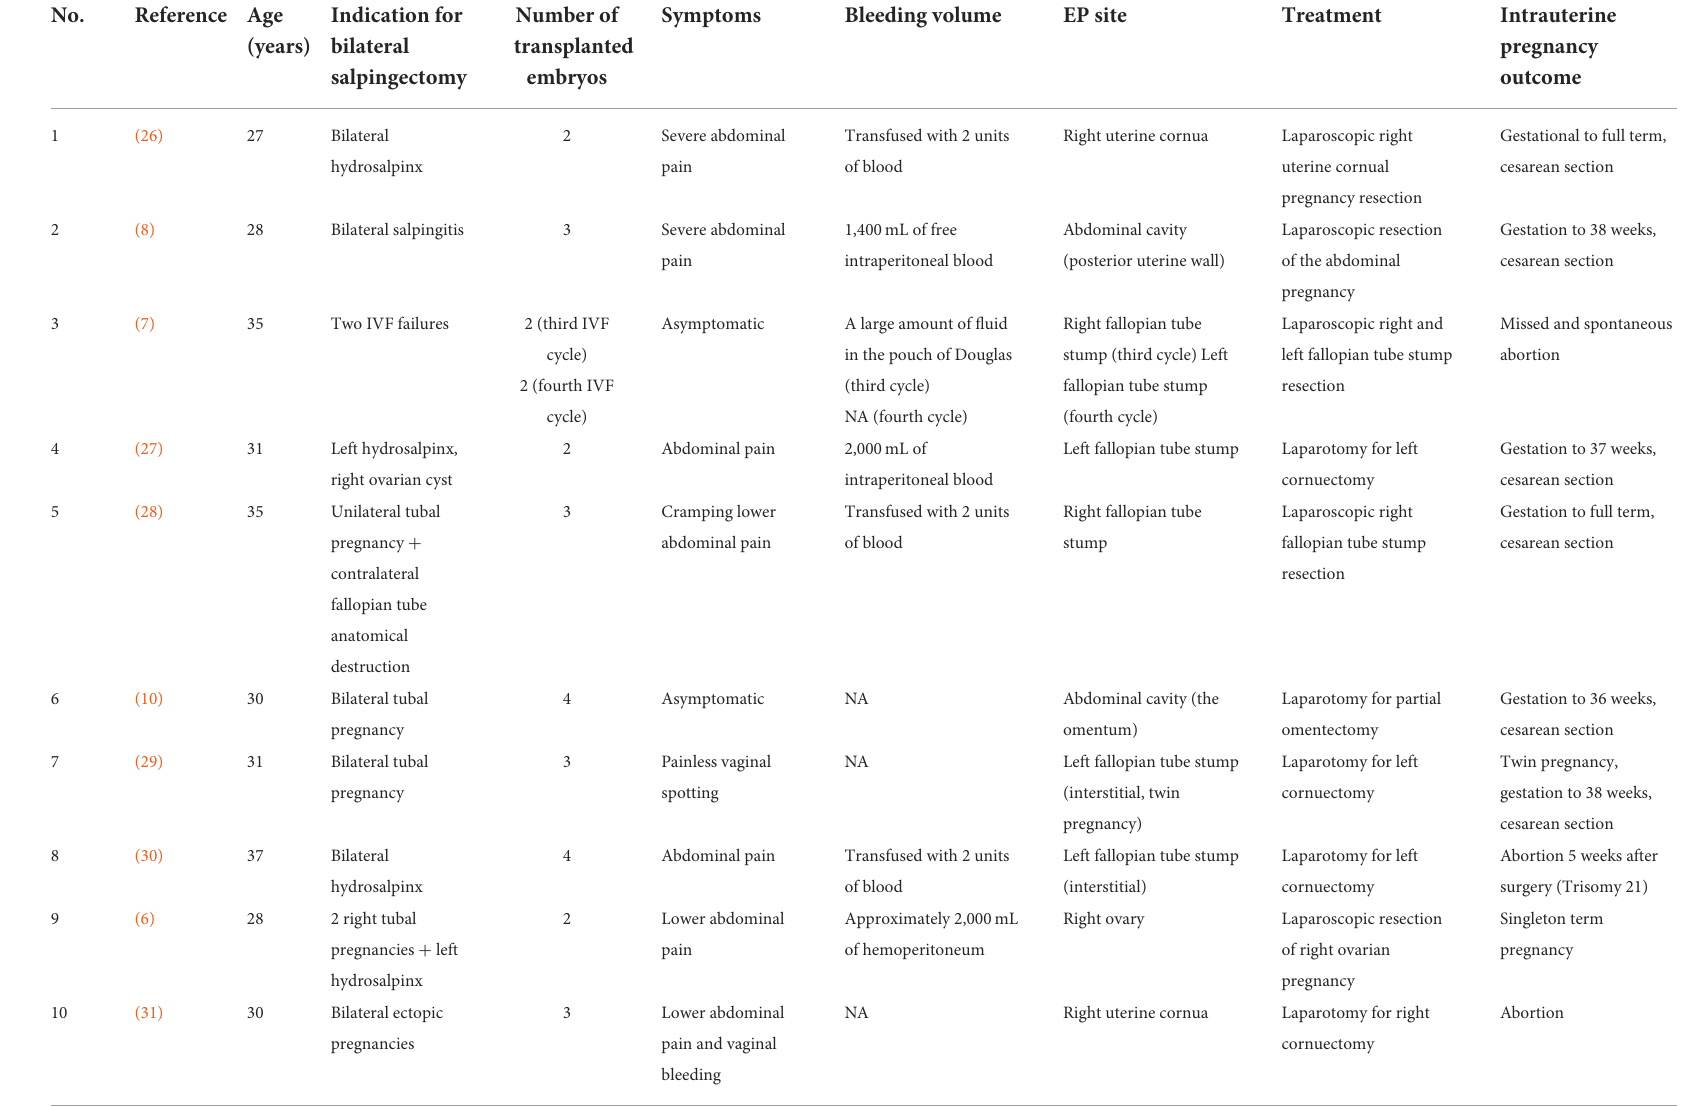
TABLE 1 Clinical characteristics of HPs after IVF-ET in patients with previous bilateral BS.